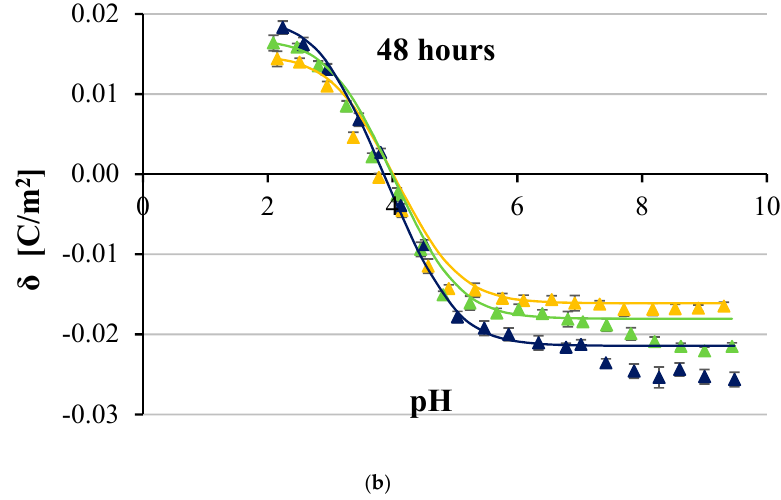
Figure 2. Dependence of surface charge density of glioblastoma LN-18 cell line as a function of the pH of the electrolyte solution. The cells were untreated (navy blue) or treated with 5 (green) and 8 (orange) mmol/dm 3 of p-coumaric acid for 24 h ( a ) and 48 h ( b ). Solid lines describe theoretical values; experimental data are marked by points.